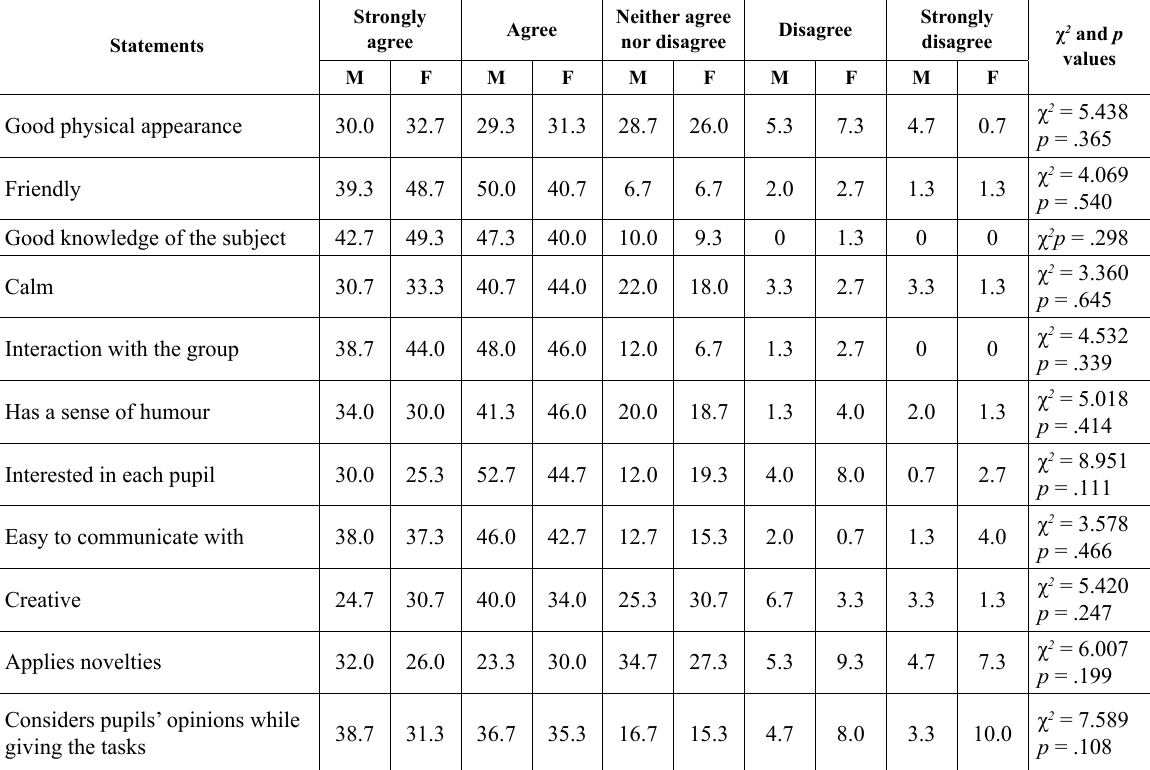
Table 1. Percentage distribution of responses to the question “What traits of the PE teacher characteristics do you